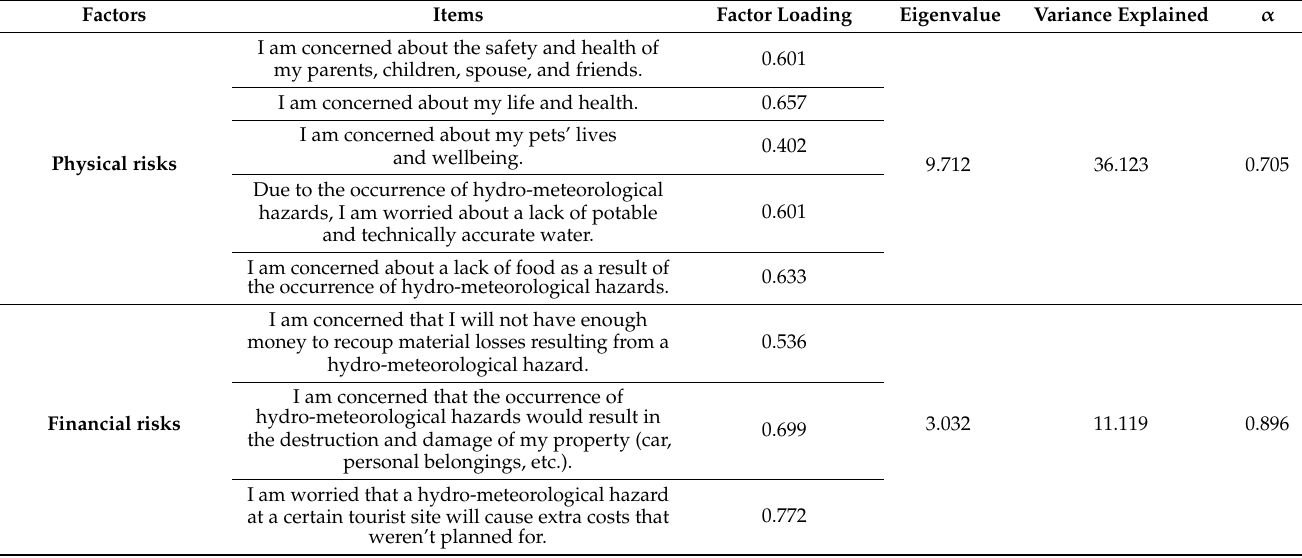
Table A1. Results of Exploratory Factor Analysis (N =